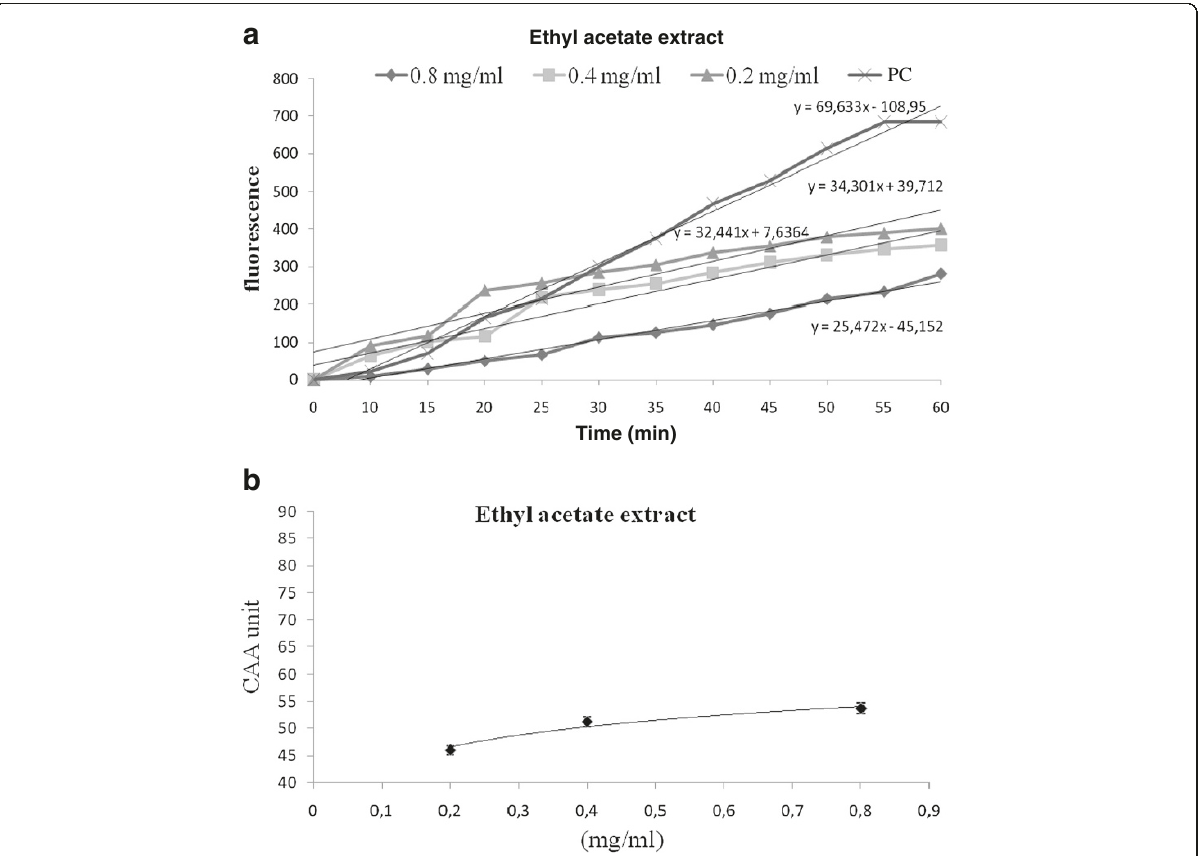
Figure 3 a. Cellular Antioxidant Activity (CAA) of ethyl acetate extract (EA extract) K562 treated cells+2 0 , 7 0 -dichlorofluorescin (DCFH)+2,2 0 -azobis (2-amidinopropane) dihydrochloride (ABAP). PC: Untreated cells+2 0 , 7 0 -dichlorofluorescin (DCFH)+2,2 0 -azobis (2-amidinopropane) dihydrochloride (ABAP). b . Dose – response curve for the inhibition of oxidation of the free-radical 2 0 , 7 0 -dichlorofluorescin